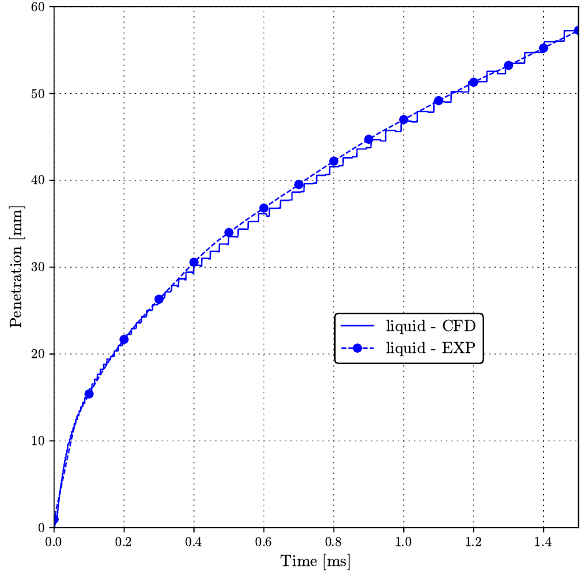
Figure 5. Liquid penetration profile.